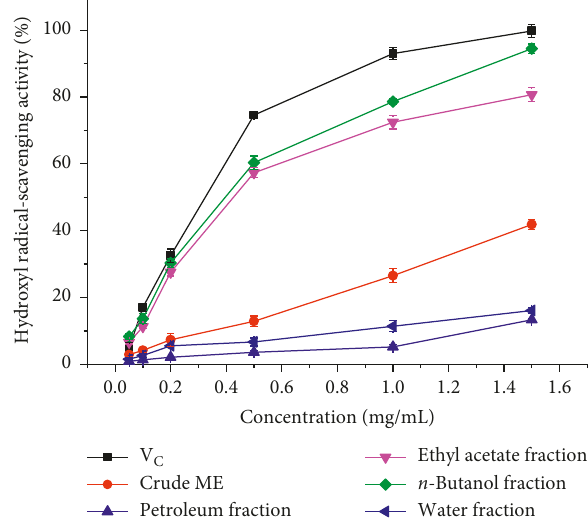
C , BB, BC, and BD Figure 8: Hydroxyl radical-scavenging activity of crude ME, V and organic extraction fractions extracted from ME.